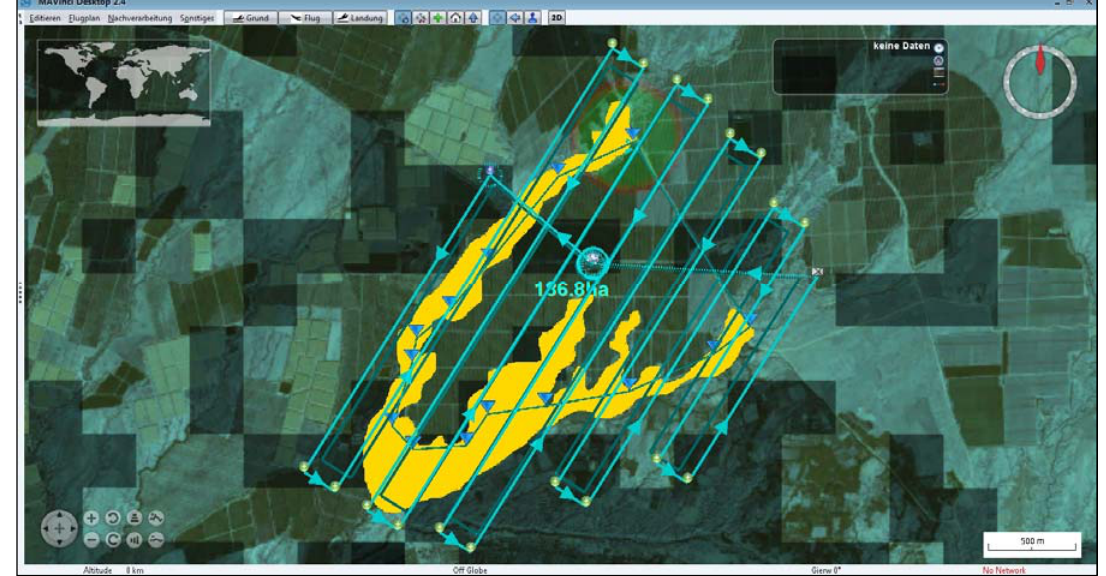
Figure 8. Flight plan for a large study site (LAS, 500 m flying